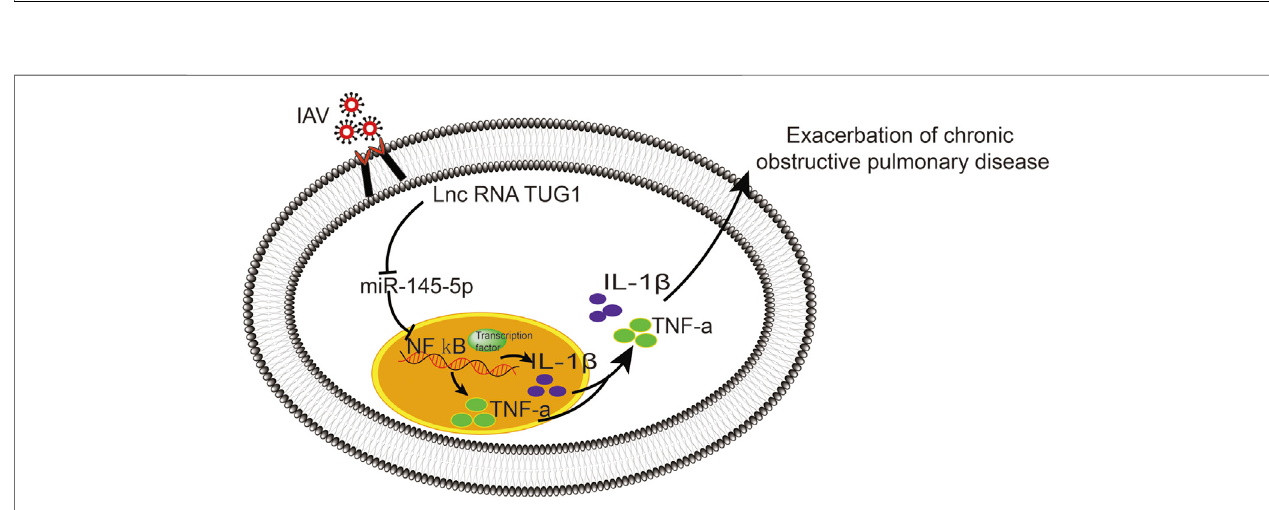
FIGURE 6 | Schematic diagram to illustrate the interactions of lncRNA TUG1/miR-145-5p/NF- κ B pathway.